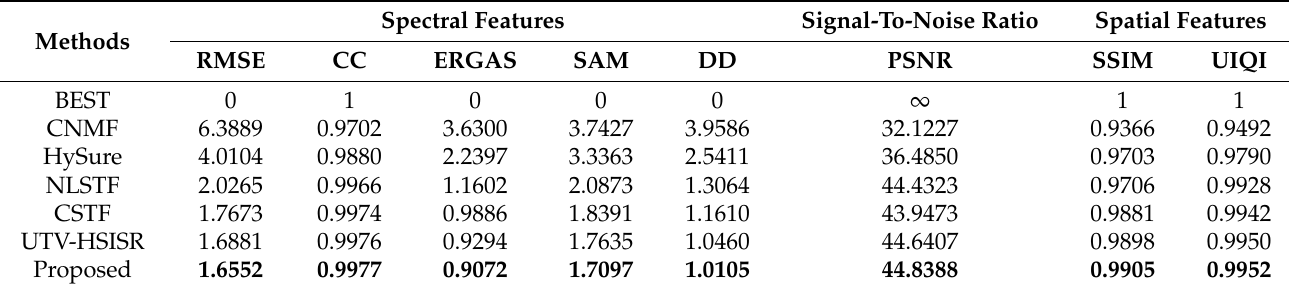
Table 2. Quality evaluation for Pavia University dataset.